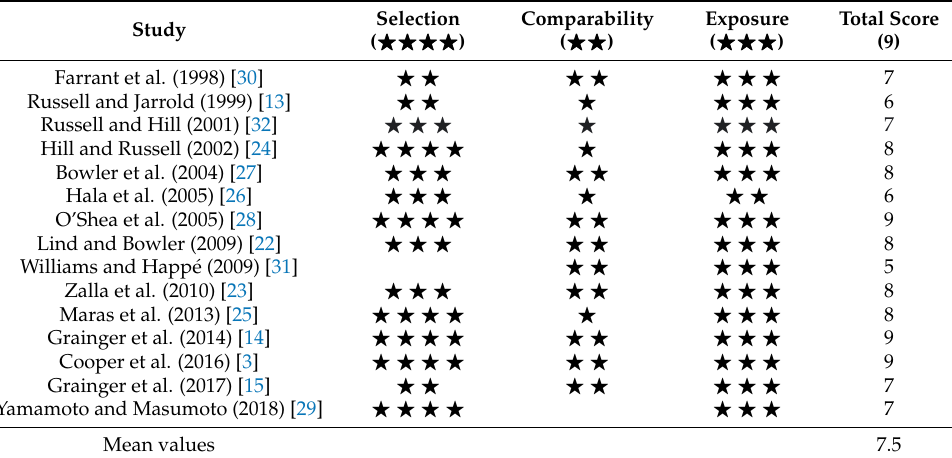
Table A1. Newcastle–Ottawa Scale for assessment of study